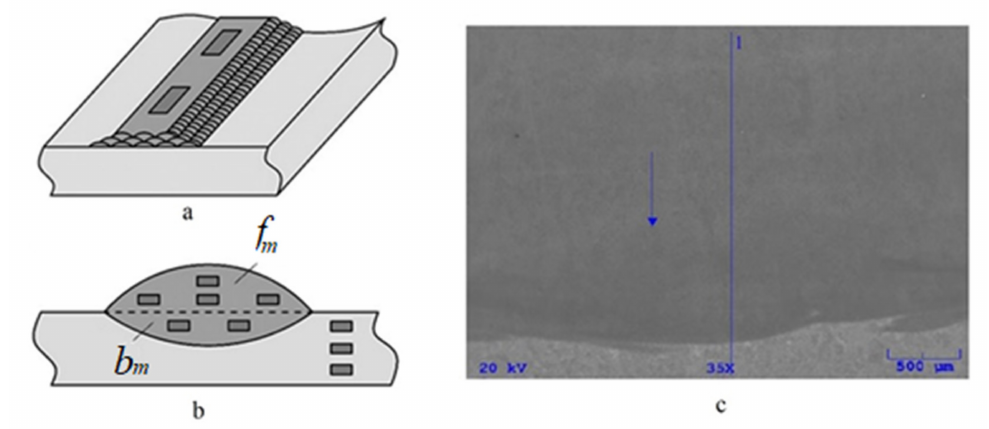
Figure 2. Methods of EDXS analysis: ( a ) Determination of the chemical composition of the filler material-schematically. ( b ) Determination of the chemical composition of the base material and in the single-bead surface welds. Schematically, f m is the area of the single-bead surface weld belonging to the filler material and b m is the area belonging to the base material. ( c ) An example of the line analysis through the fusion line (surface weld no.